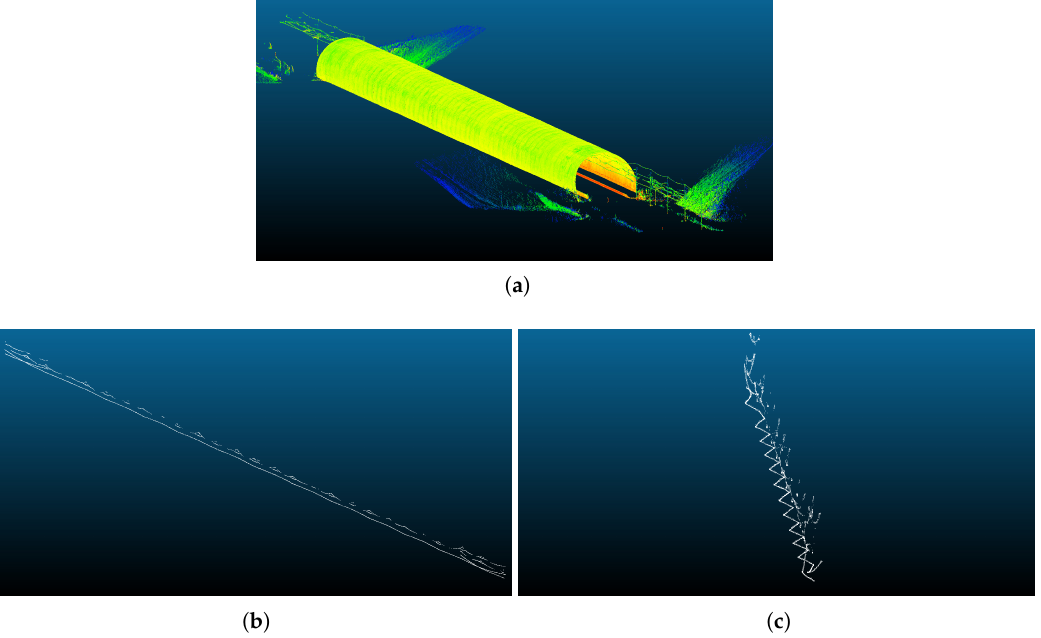
Figure 9. Point cloud recorded in a real tunnel railway environment and the points classified by the method as belonging to a wire in this point cloud. ( a ): a perspective of the point cloud recorded in the real environment; ( b ): points classified as contact or messenger wires by the new method; ( c ): a different perspective of the classified